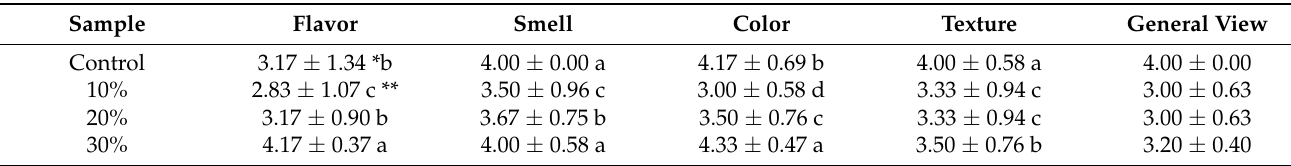
Table 4. Sensorial properties of bread samples with coriander seed